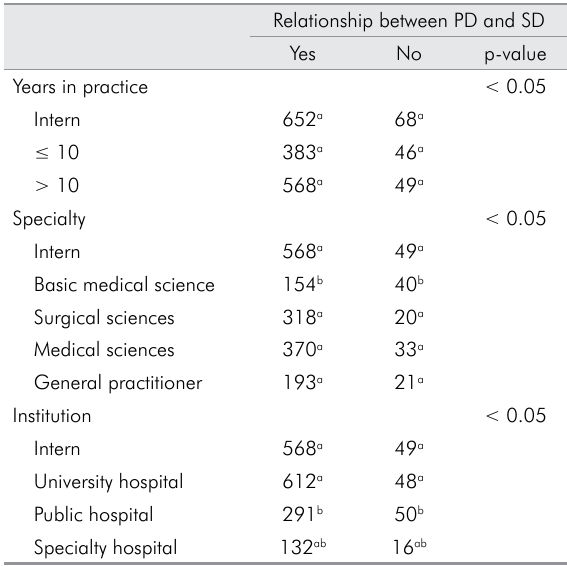
Table 2. Number of responding doctors who supported or denied the existence of a relationship between PD and